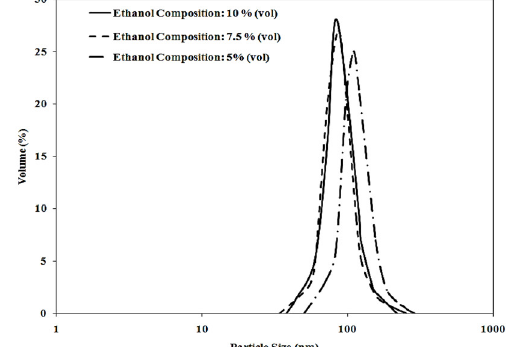
Fig. 5. Size distribution of paclitaxel particles obtained at 50˚C, 3 mL/min, DMSO/water ratio of 6 (v/v) and various ethanol concentrations of 5, 7.5 and